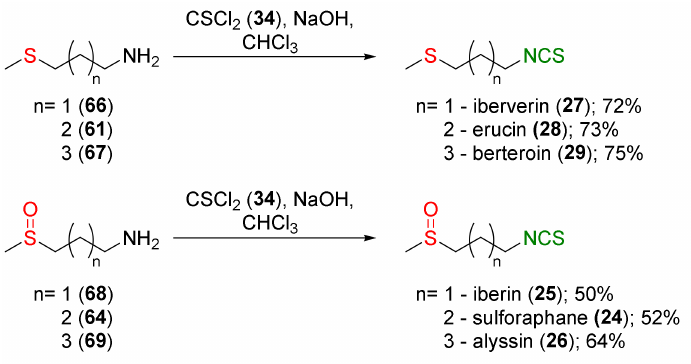
Figure 18. Synthesis SFN ( 24 ), erucin ( 28 ), and their analogs using thiophosgene. The bactericidal activity against H. pylori of synthesized ITCs was tested. All tested ITCs ( 24 – 29 ) showed strong anti- Helicobacter activity at the level of a 5 mg/disk exhibiting >5 cm inhibitory zones.